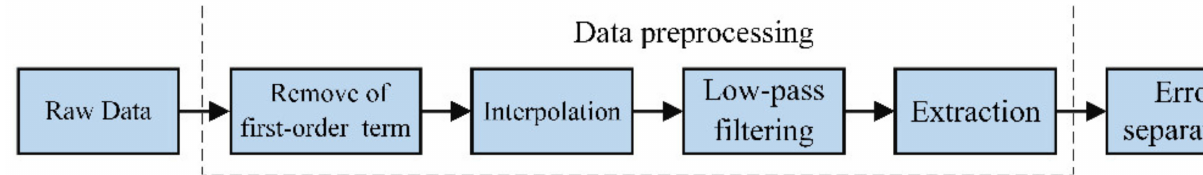
Figure 5. Example of the raw output signals of the displacement-based sensors.